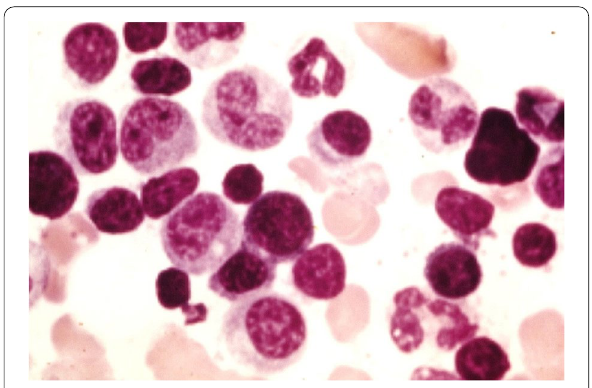
Fig. 1 Microscopic imaging